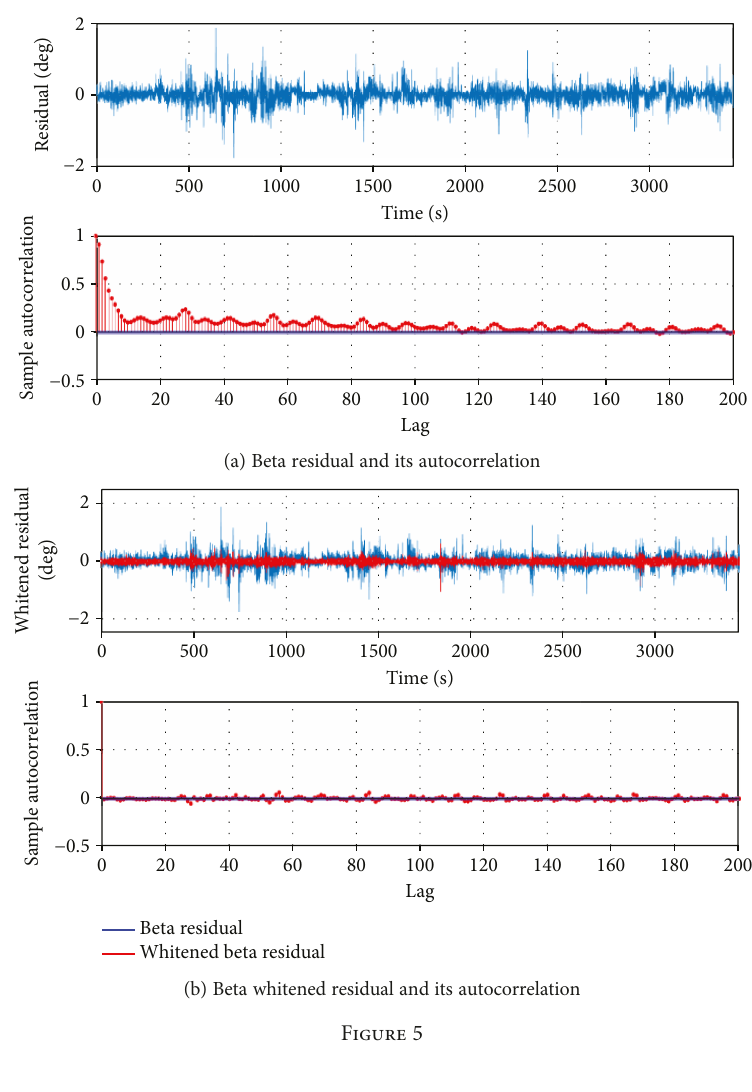
Table 6: Values of the λ parameter for an optimized design of the